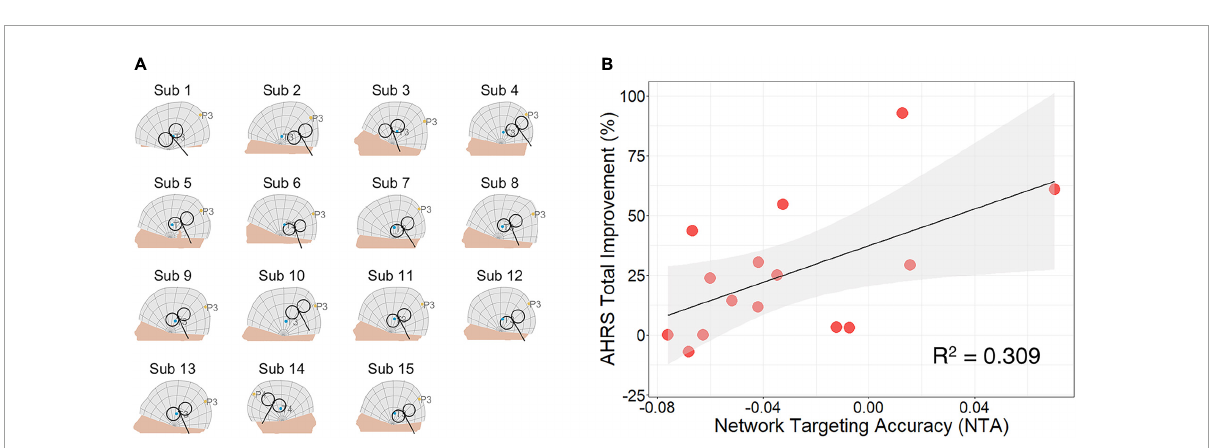
FIGURE4 Network targeting accuracy predicts treatment efficacy in the clinical cohort of schizophrenia with auditory verbal hallucinations (AVH). (A) Coil placement of active group patients shown on individual head models. (B) Correlation between network targeting accuracy (NTA) and auditory hallucination rating scale (AHRS) total improvement ( N = 15, p = 0.016,